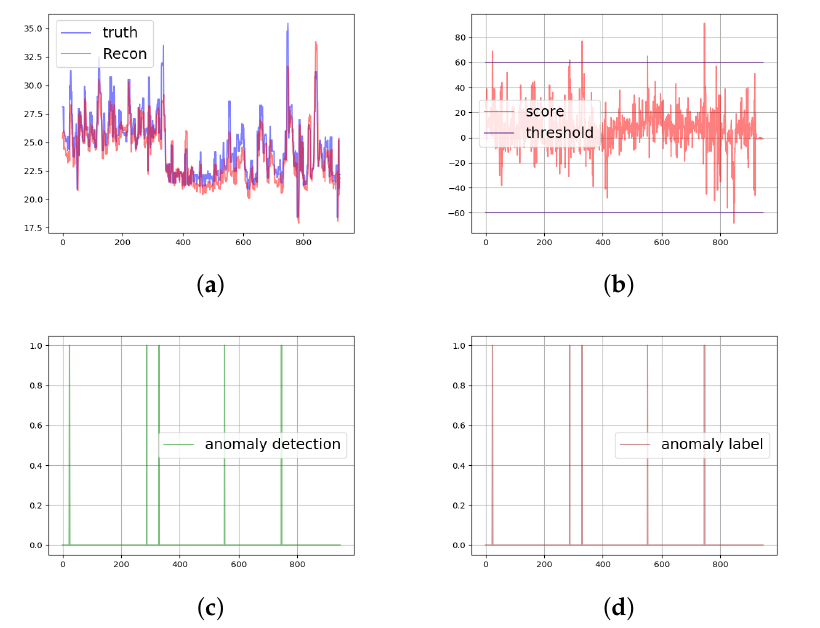
Figure 4. Visualization analysis of anomaly detection. ( a ) The reconstruction results. ( b ) Anomaly scores. ( c ) Anomaly detection results. ( d ) Anomaly